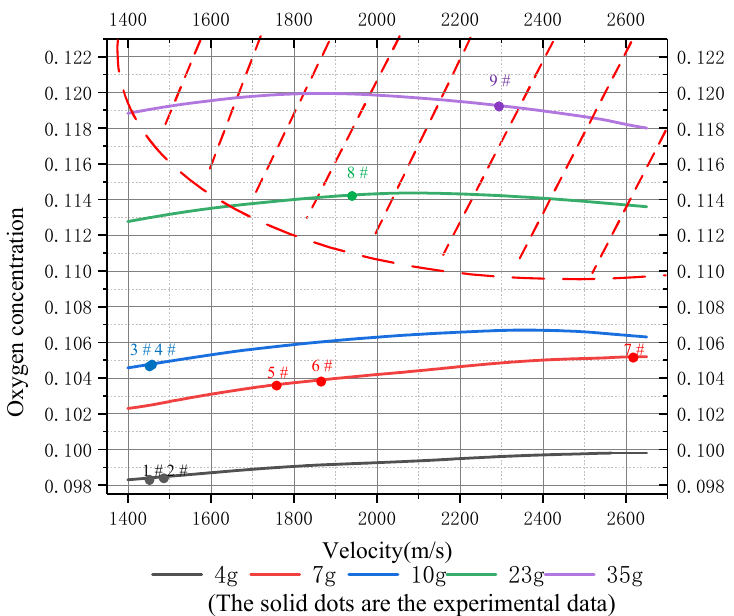
(The solid dots are the experimental data) Figure 14. Variation in oxygen concentration (volume fraction) in the fuel tank with velocity sub- jected to inert fragments with different